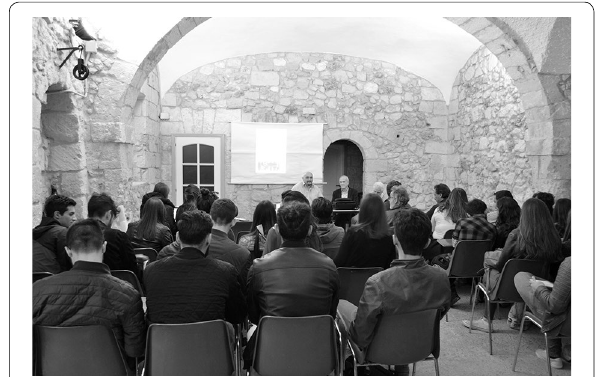
Fig. 4 Meeting with citizenship. Photo: R. Filippelli